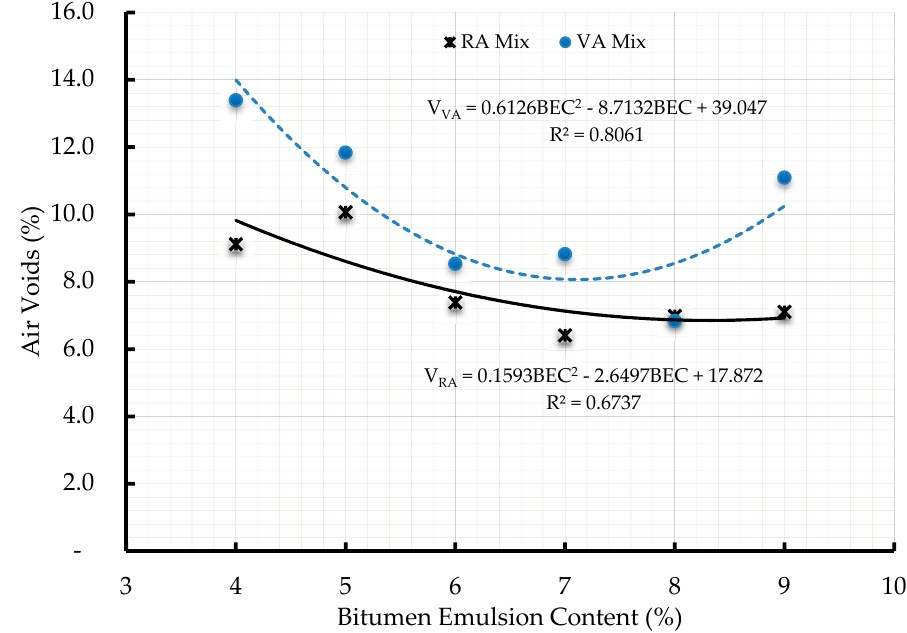
Figure 7. Air voids for Virgin Aggregates and Reclaimed Asphalt Mixes at Optimum Bitumen Emulsion Content.